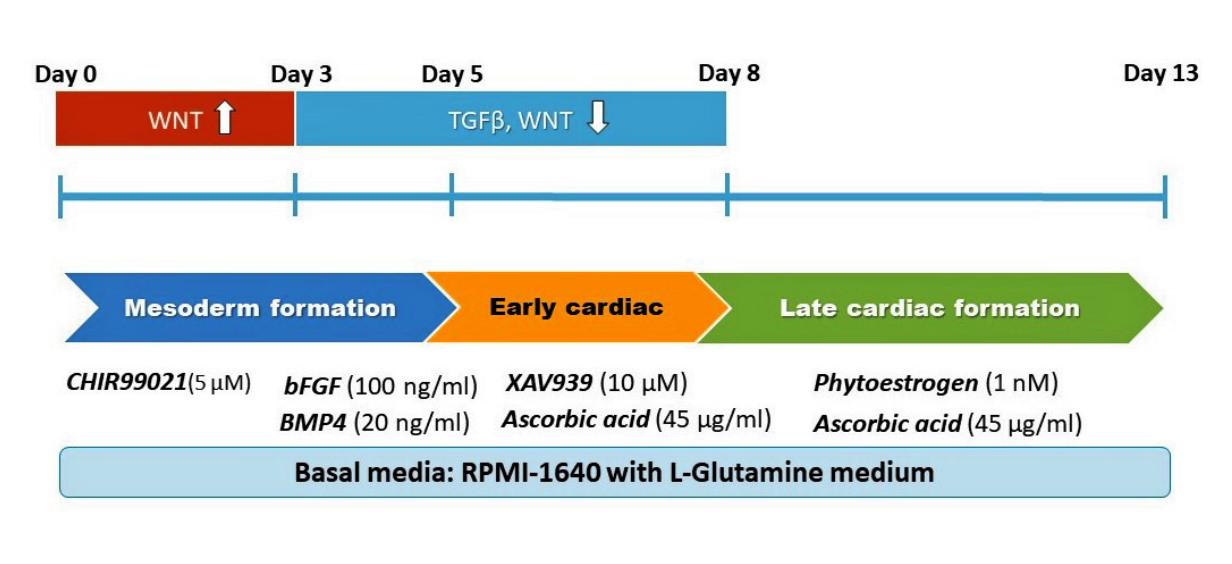
Fig. 1. Schematic representation of our cardiomyocyte differentiation approach